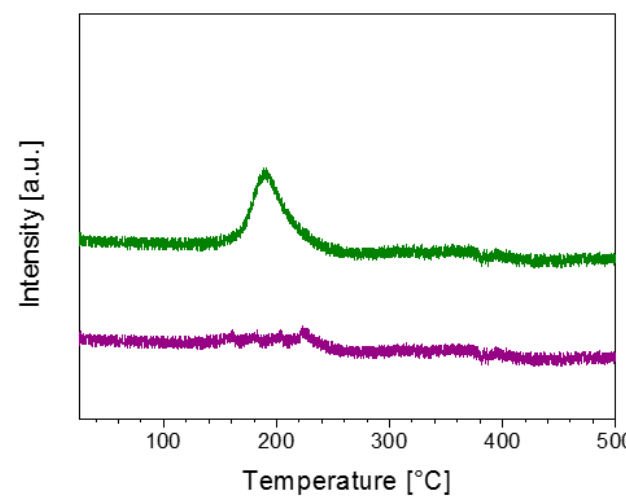
Figure 6. TPR analyses of CuO-TiO 2 sample (green curve) and Au-TiO 2 sample (violet curve).